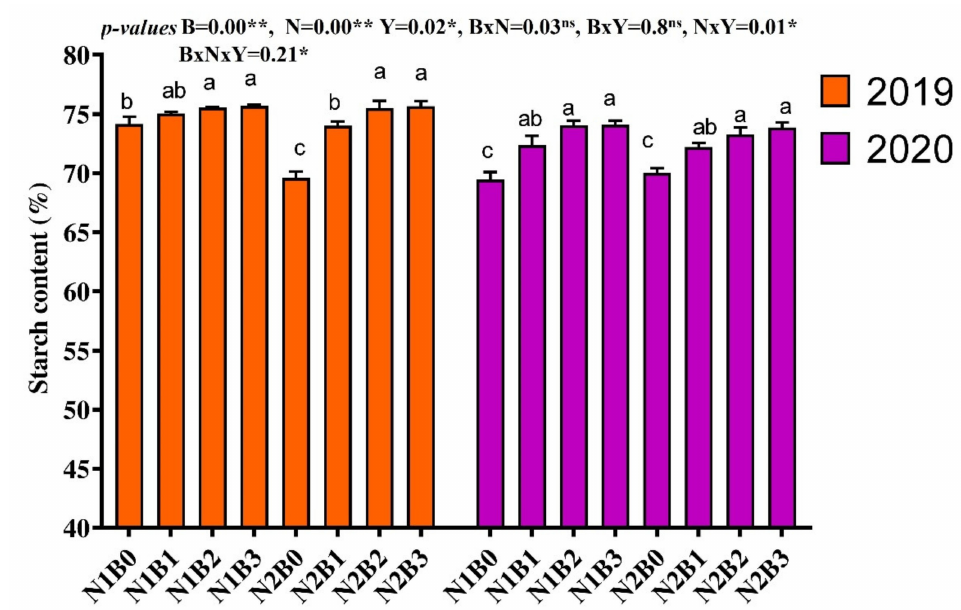
Figure 4. Changes in starch content of rice in response to different biochar and nitrogen fertilizer. Bars represent the standard errors of the means. ** and * on the B, N, and Y indicate significance at the 0.01 and 0.05 probability levels, respectively. ns; non-significant. Columns with different letters are significantly different at p < 0.05. N1 and N2 represent 135 and 180 kg ha − 1 nitrogen; B0, B1, B2, and B3 represent 0-, 10-, 20-, and 30-ton biochar ha − 1